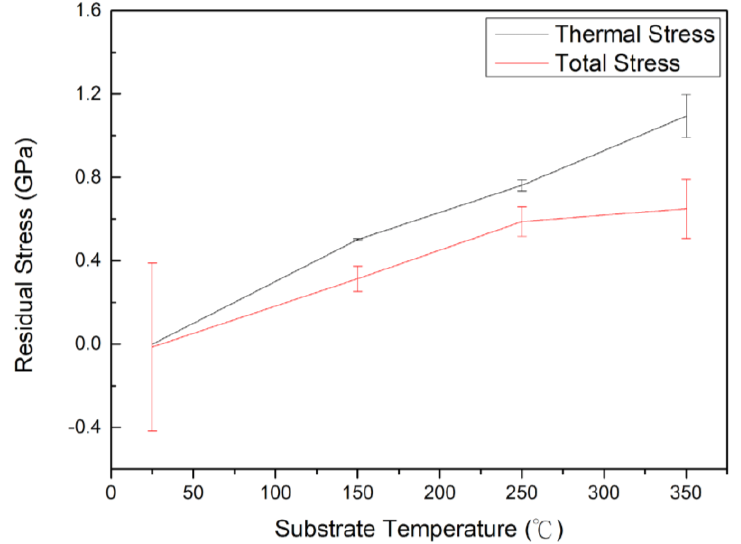
Figure 7. The residual stress of CoCrFeNi film as a function of substrate temperature.